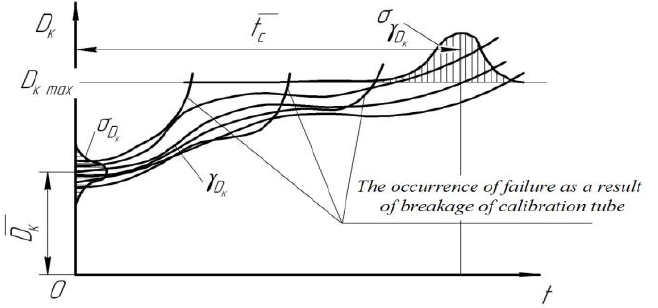
Fig. 6. The dependence of change of the calibration opening on run-in